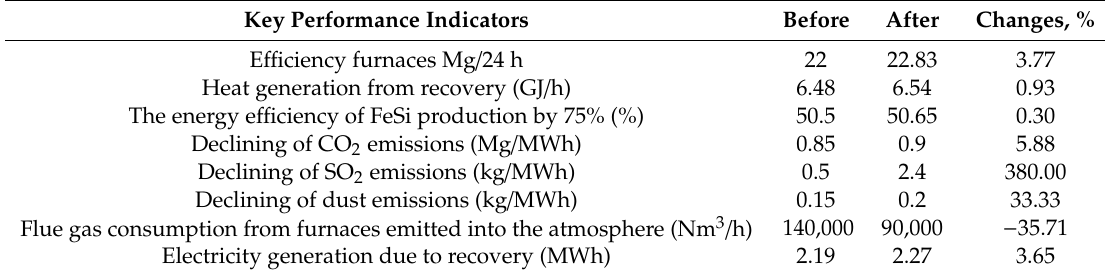
Table 3. A comparative analysis of the technological and ecological indicators of the company’s performance with and without the energy recovery system (calculation for